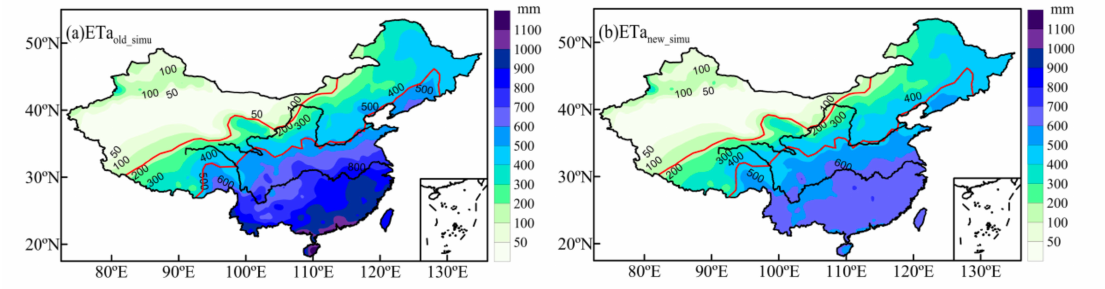
Figure 3. ET a distribution (1981–2010 average) before ( a ) and after ( b ) improvement.